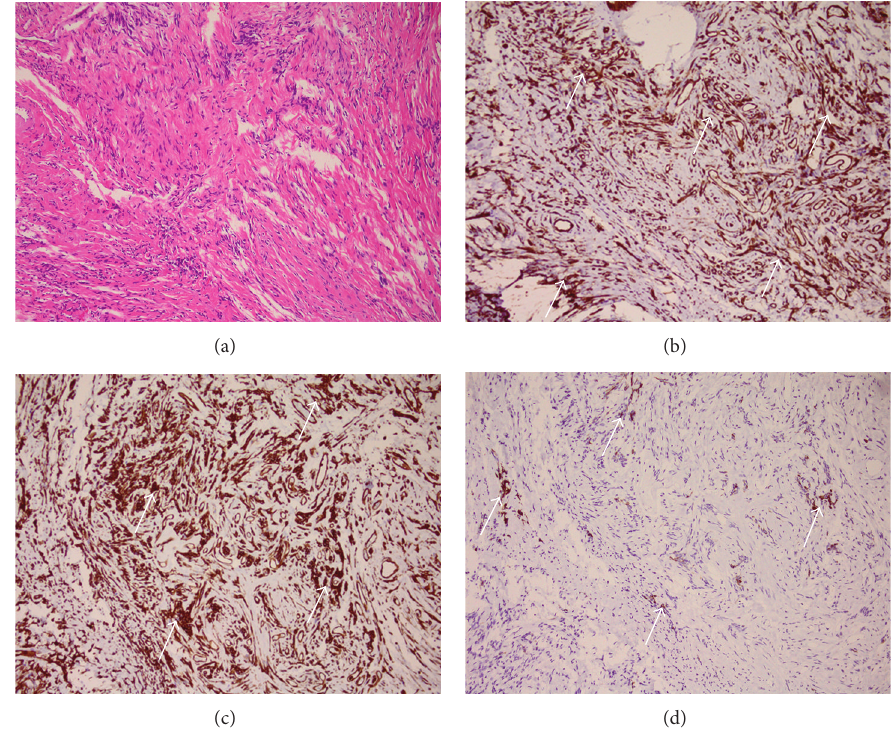
Figure 2: Histological examination of the postcricoid SFT (magnification in all images 100x). (a) Abundant spindle-shaped tumor cells with characteristic whorled arrangement (hematoxylin and eosin staining); (b) strong CD34 immunoreactivity (arrows); (c) strong vimentin immunoreactivity (arrows); (d) focal and weak desmin immunoreactivity (arrows).